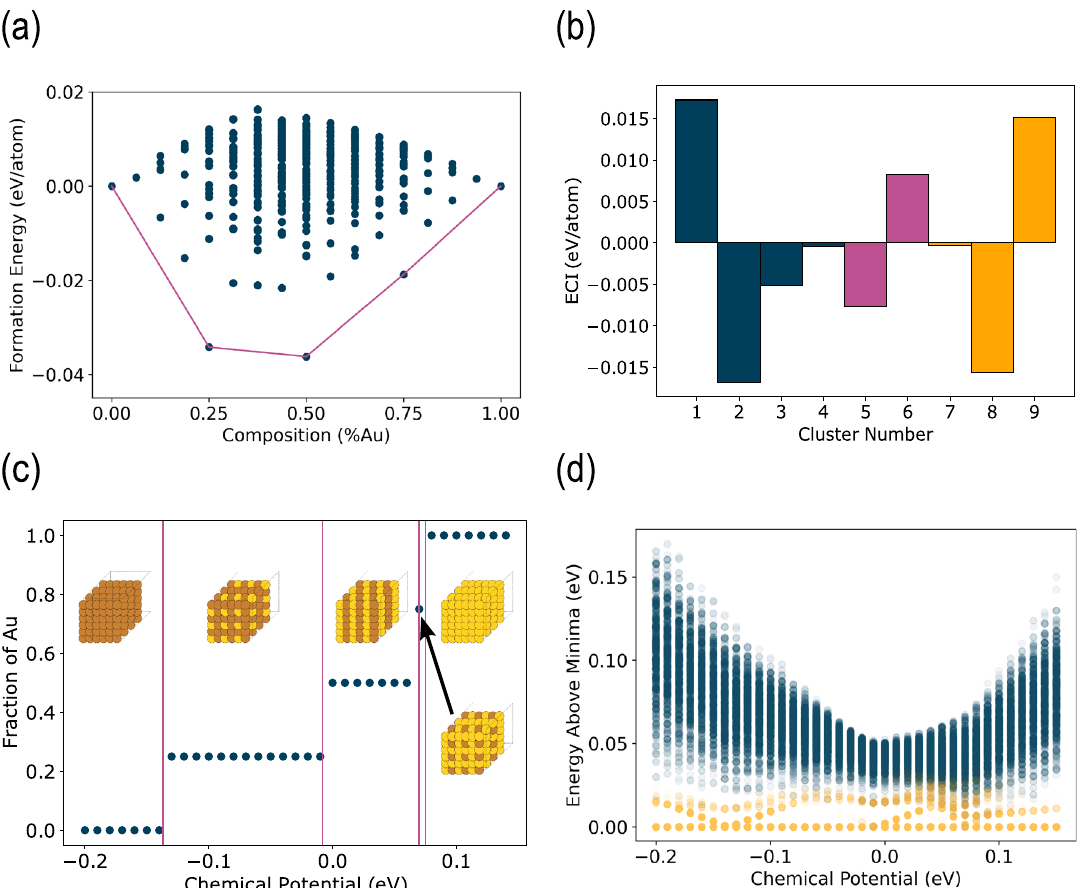
Fig. 3 CuAu ground states. a Formation energies of all 2 16 = 65,536 possible decorations of 16-site fcc prototype lattice according to the model cluster expansion. b Effective cluster interactions (ECI) of two-body (blue), three-body (purple), and four-body (orange) clusters obtained using CLEASE 4 . c Ground states sampled as a function of chemical potential. Cells are expanded by nine times to aid visualization. Purple lines denote expected transitions based on the cluster expansion energy function. d Comparison of sampling of grand potential minima with SEGAL (orange) and random search